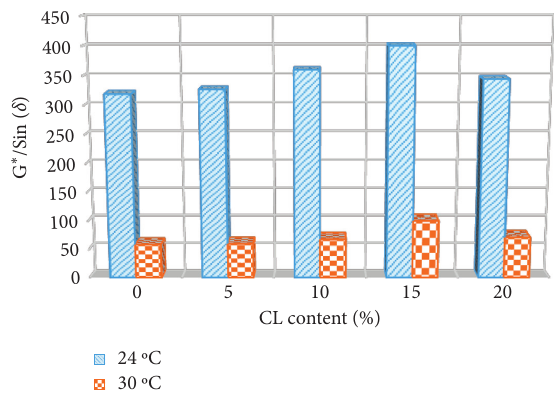
Figure 12: The results of G ∗ · sin( δ ) parameter at temperatures of 24 ° C and 30 ° C.